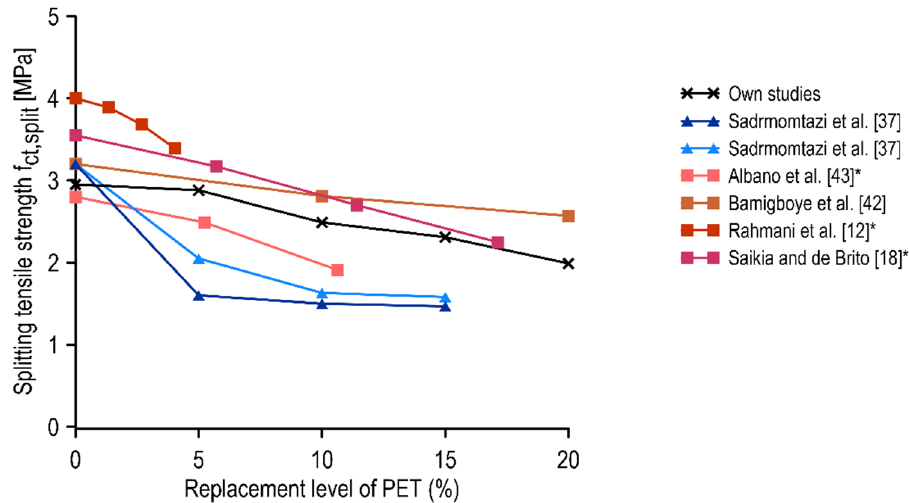
Figure 9. Variation of 28-day splitting tensile strength of different concrete with respect to the replacement level of PET. * Converted from volume replacement.